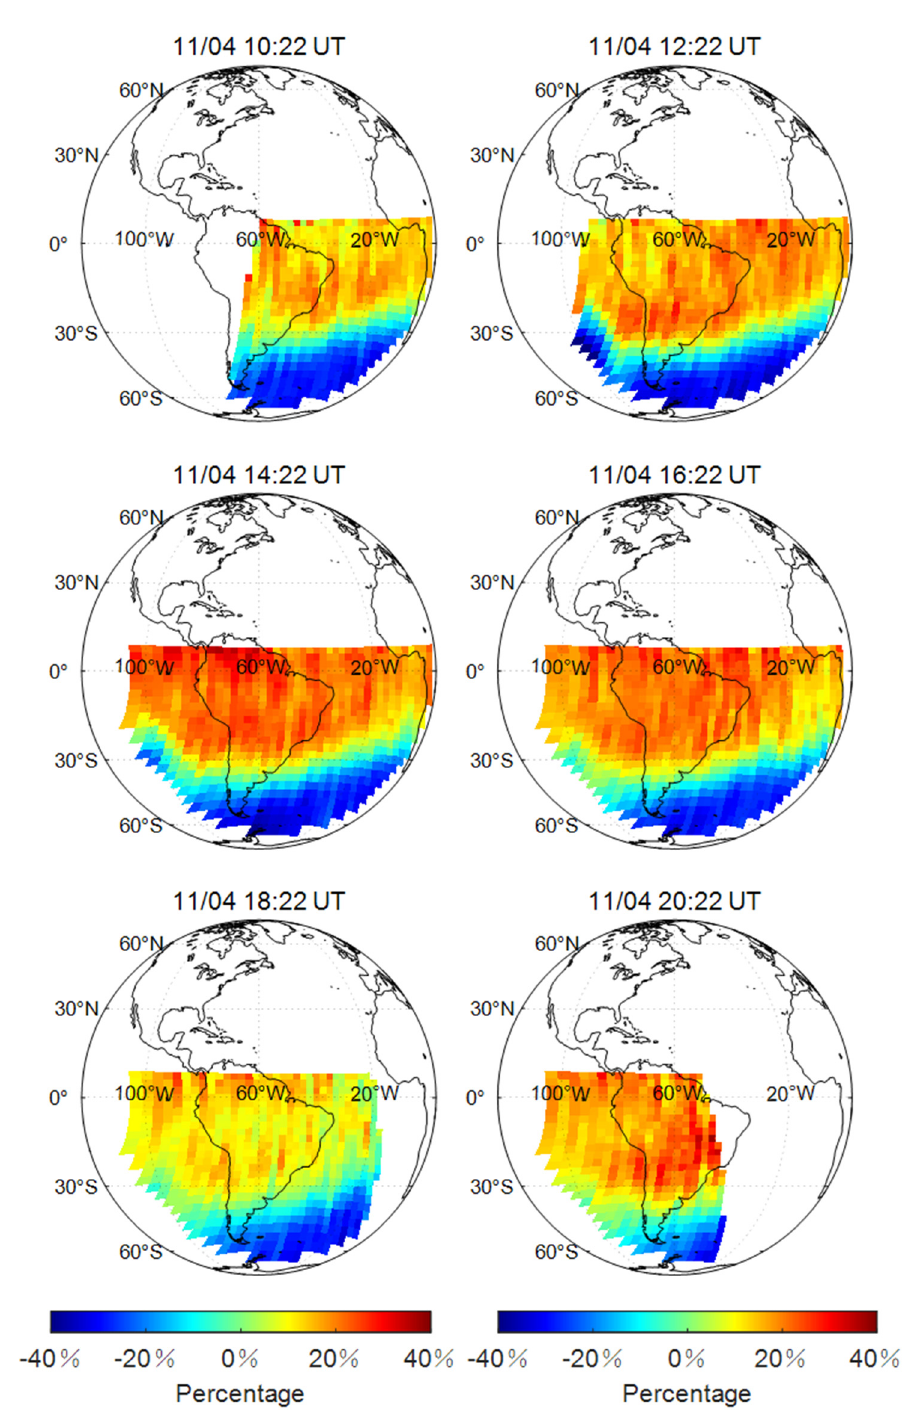
Figure 5. Relative differences in GOLD ∑ O/N 2 between the storm day and the quiet day.